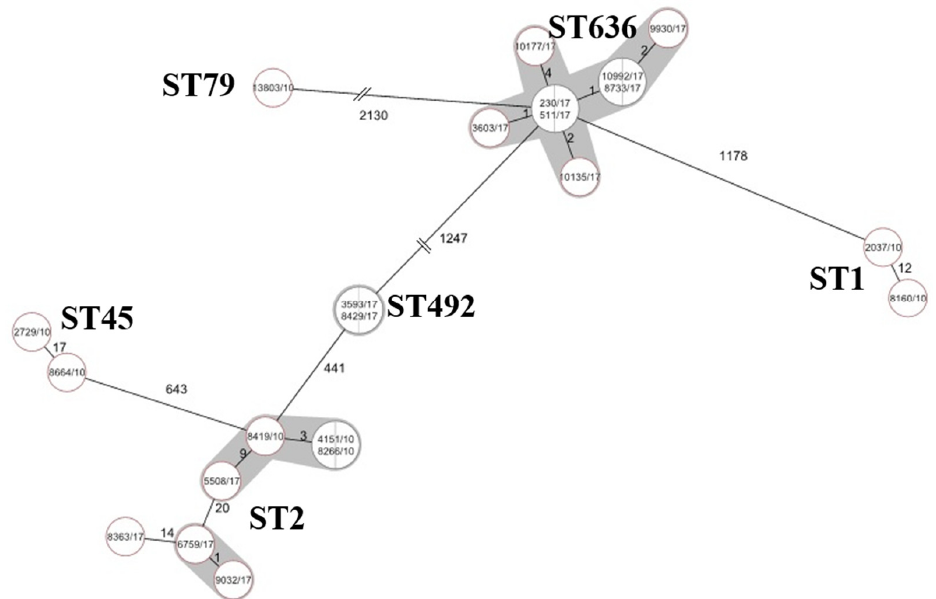
Figure 2. Phylogenic tree of sequenced A. baumannii isolates based on core-genome multilocus sequence typing (cgMLST). Minimum spanning tree based on cgMLST allelic profiles of 22 A. baumannii isolates. Each circle represents an allelic profile based on sequence analysis of 2390 cgMLST target genes. The numbers on the connecting lines illustrate the numbers of target genes with different alleles. Closely related genotypes (<10 alleles difference) are shaded.